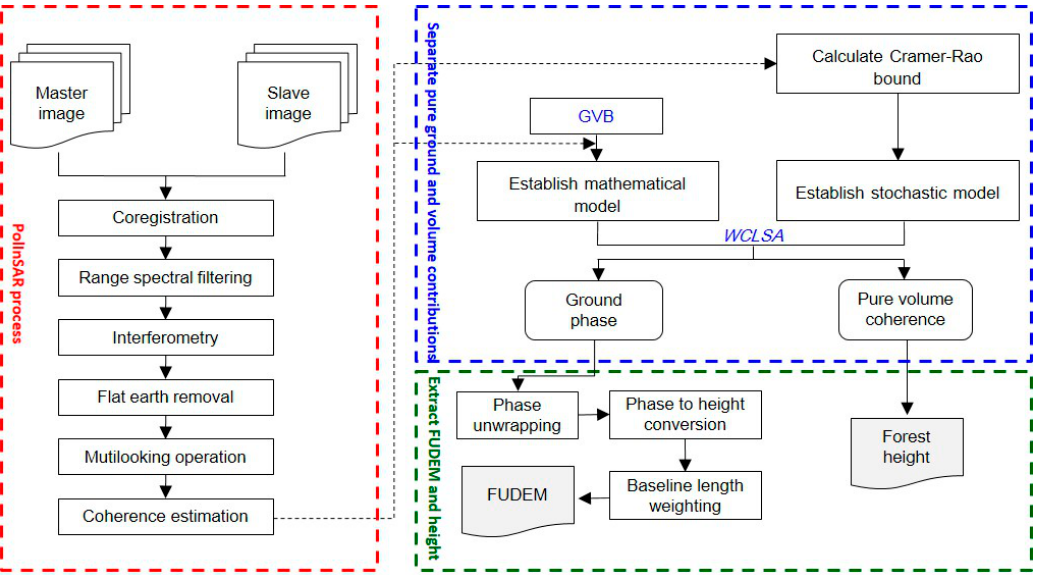
Figure 3. Flowchart of the proposed weighted complex least squares adjustment (WCLSA) algorithm.